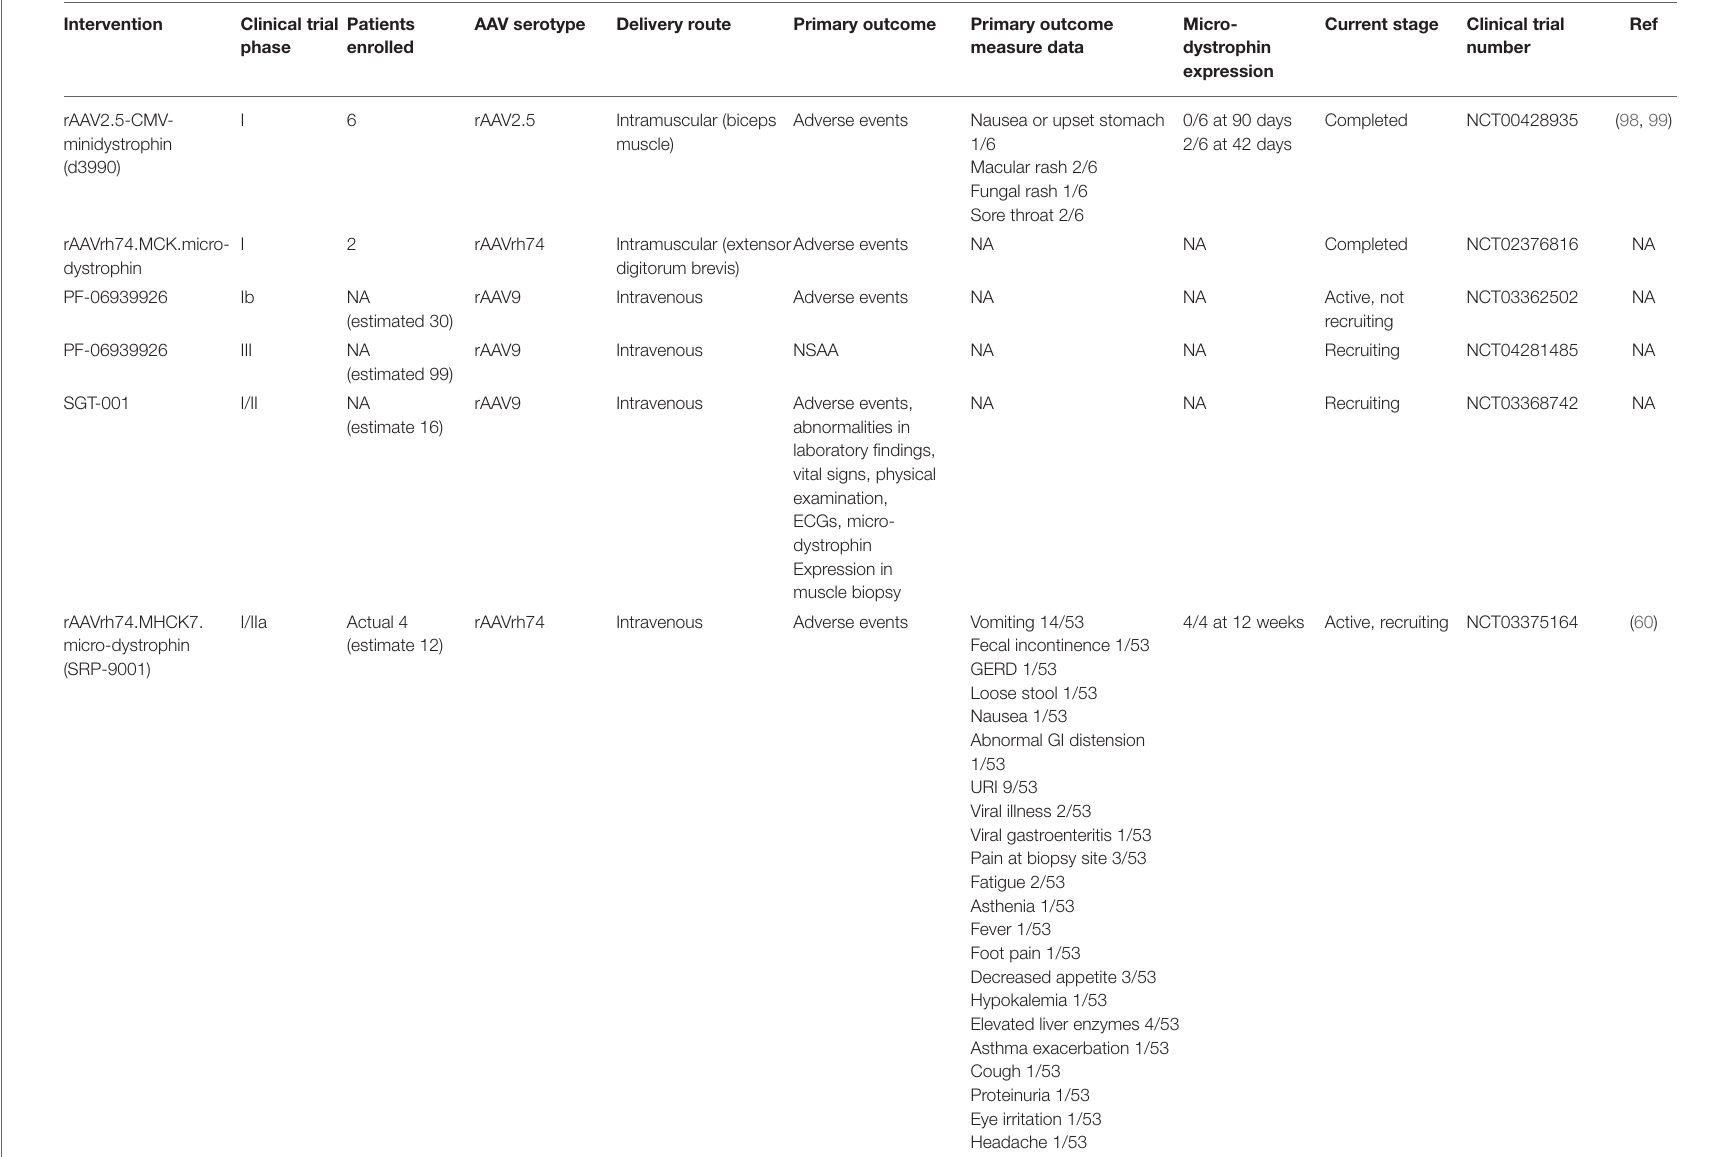
TABLE 2 | Clinical trials of AAV-mediated gene therapy in DMD. Intervention Clinical trial Patients AAV serotype Delivery route Primary outcome Primary outcome phase enrolled